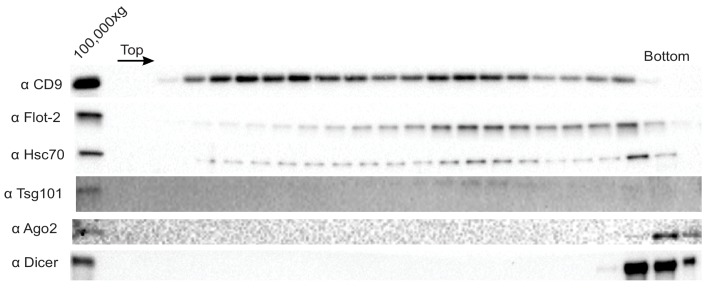
Ago2 and Dicer are not sEV-associated in MB-MDA-231 cells.Immunoblot for sEV markers across the linear ioxidanol gradient as depicted in Figure 1a, except that the sucrose cushion step to sediment and concentrate the vesicles was not included. Therefore the amount of sedimentable material subjected to flotation was diminished.